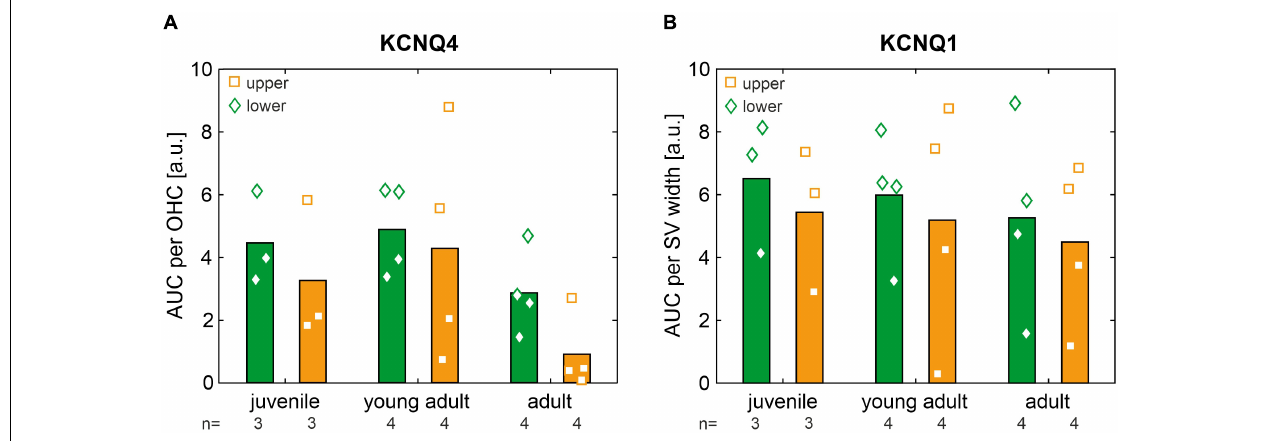
FIGURE 8 | (A) Area under the curve (AUC) of KCNQ4 immunofluorescence normalized per outer hair cell (OHC) and averaged from cochlear cross-sections in the apical, middle, and midbasal turns for mice allocated to the lower (green diamonds) and upper (orange squares) quartiles in each age group (juvenile, young adult, and adult). Grand means are shown as bar graphs. (B) Same as panel (A) for the AUC of KCNQ1 immunofluorescence normalized per stria vascularis (SV)